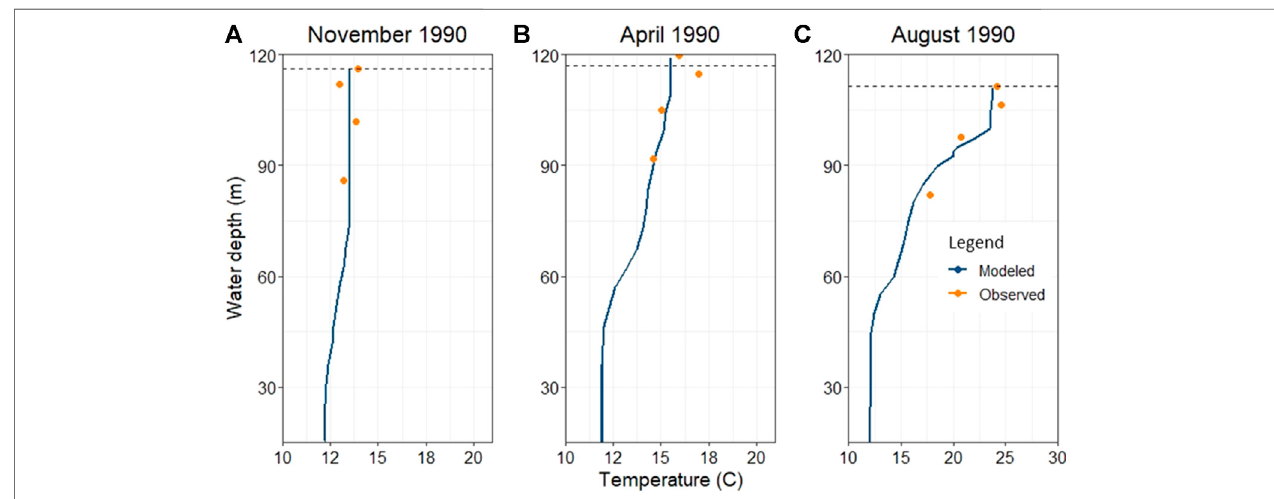
FIGURE 5 | Water temperature comparison through depth for different seasons (A) autumn, (B) spring, and (C) summer. Y axis represent the elevation from the bottom of the dam.